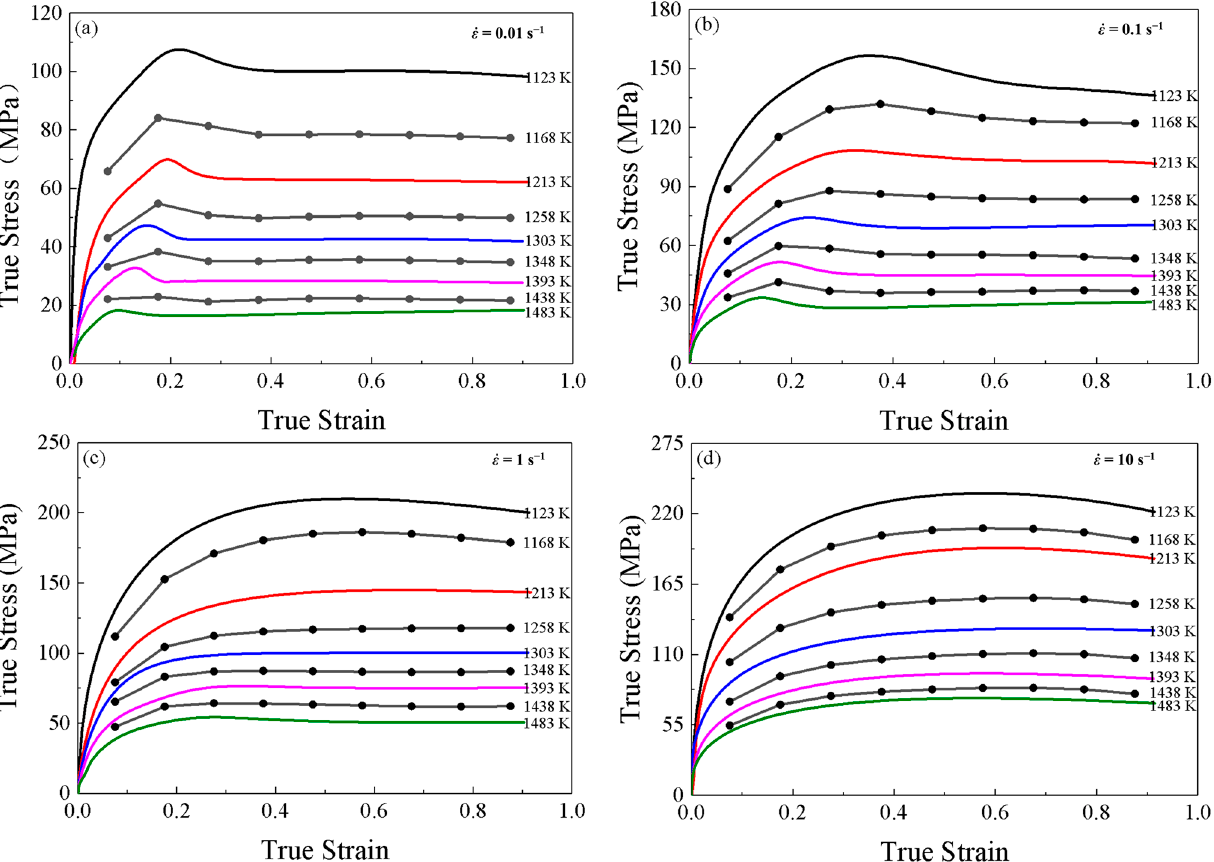
Figure 13. The experimental and predicted results of true stress-strain curves for SAE 5137H steel under different temperatures and strain rates of ( a ) 0.01 s − 1 , ( b ) 0.1 s − 1 , ( c ) 1 s − 1 and ( d ) 10 s − 1